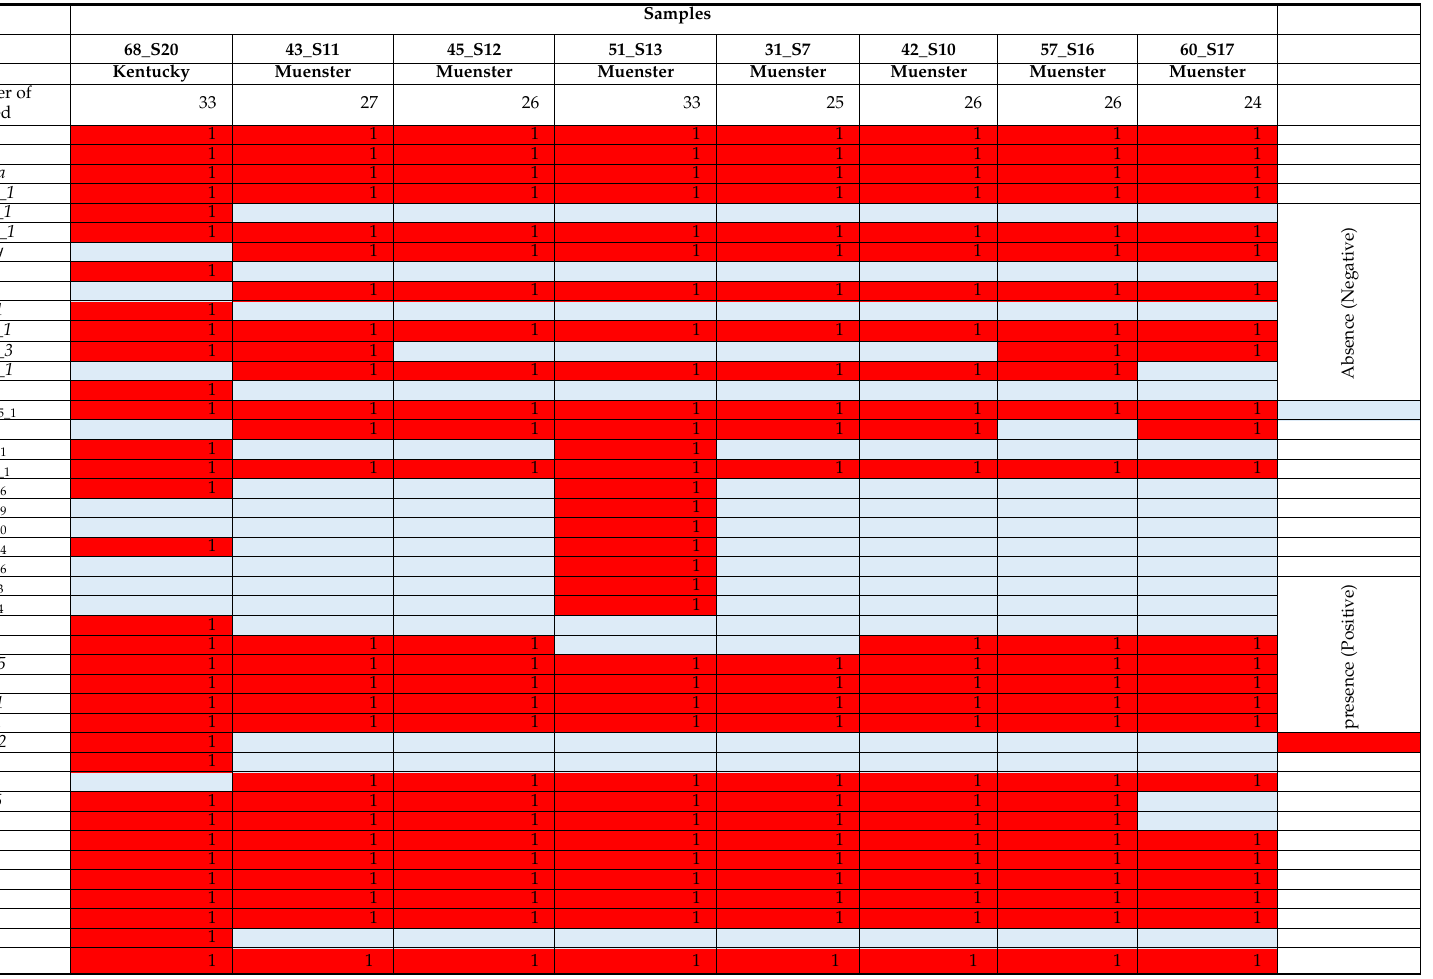
Table 3. Distribution of ARG in Salmonella serovars based on in silico